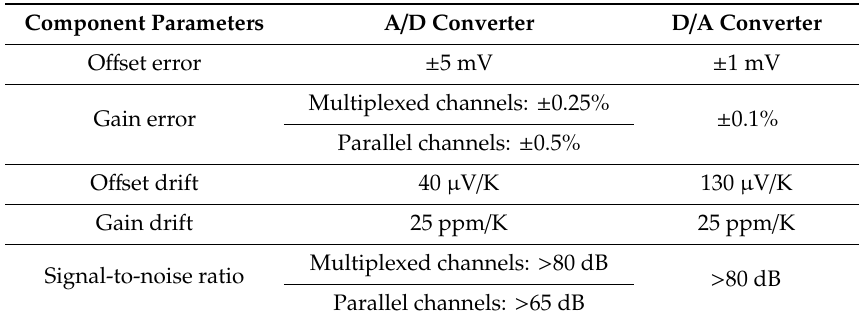
Table 2. The error specification of quad-core AMD (advanced micro devices) processors (DS 1104) board